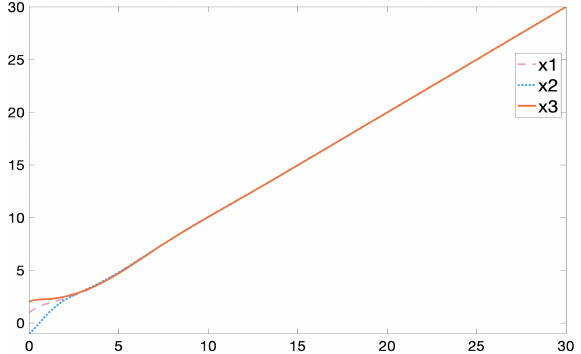
Figure 9. Displacement of Three Followers’ Hanging